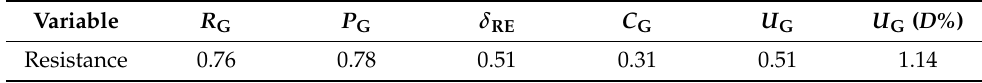
Table 5. Results of grid dependence study for intact ship ( Fr =